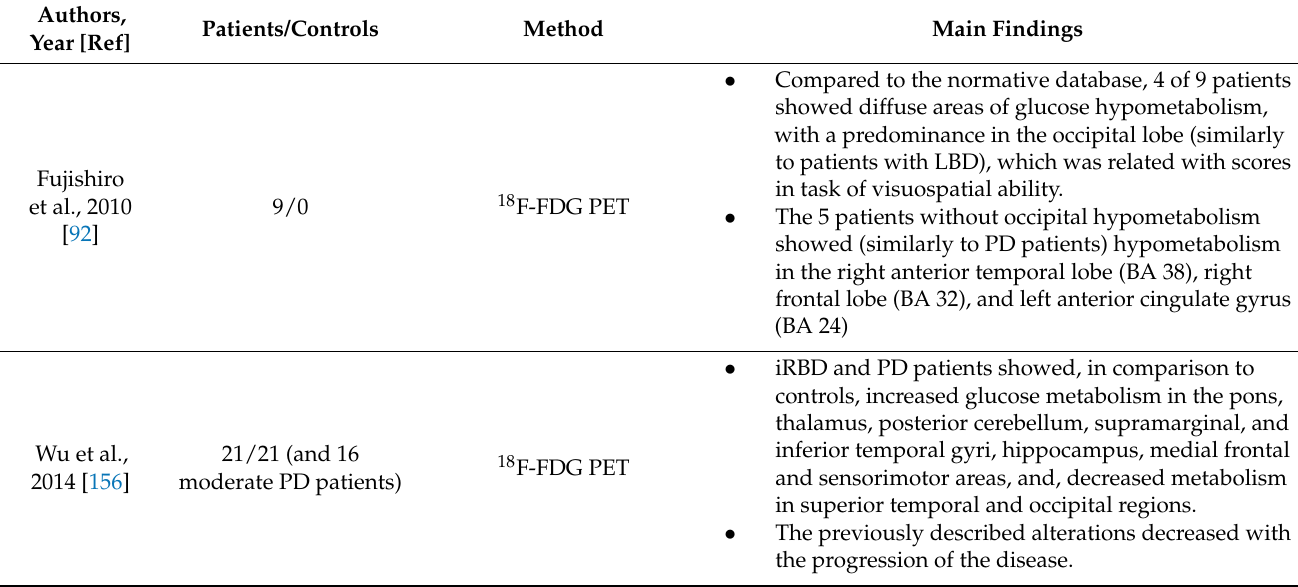
Table 3. Studies assessing cerebral glucose metabolism in patients with RBD. AD Alzheimer’s disease; BA Broddmann areas; 11 C-CFT: 2b-carbomethoxy-3b- (4-trimethylstannylphenyl) tropane; DAT dopamine transporter; dnPDRBD-RP de novo PD RBE related pattern; EMG electromyography; 18 F-FDG: 18 F-fluoro-d-glucose; 18 F-FP-CIT: 18 F-N-(3-fluoropropyl)-2beta- carbon ethoxy-3beta-(4-iodophenyl) nortropane;iRBD-AB idiopathic RBD with abnormal DAT scan; iRBD-RN idiopathic RBD with relatively normal DAT scabn; iRBD-RP idiopathic RBD related pattern; LBD Lewy body dementia; MCI: mild cognitive impairment; PD Parkinson’s disease; PDRP PD related pattern; PPDRBDRP PD-RBD related pattern; PET: